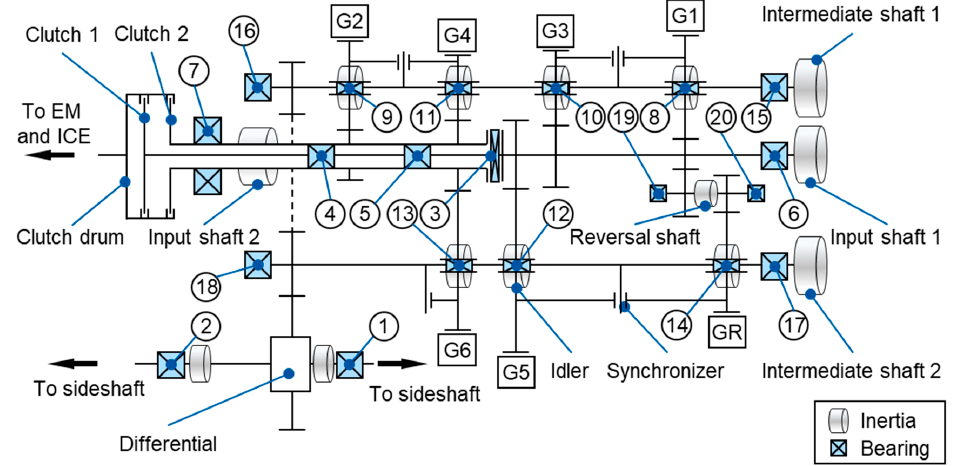
Figure 2. Transmission layout and structure of its torsional rigid-body model.